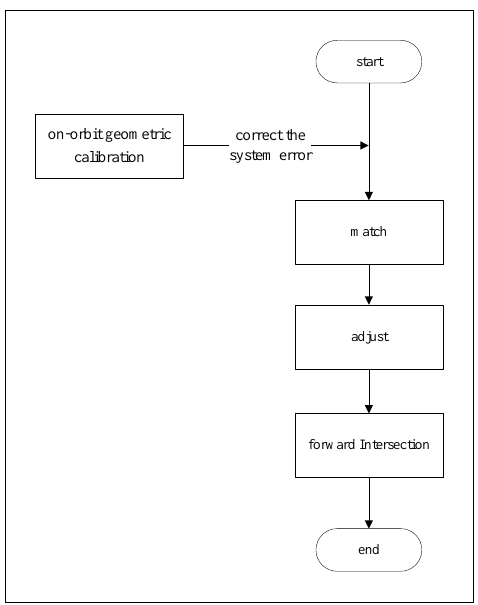
Figure 1. the solution of positioning accuracy without ground control